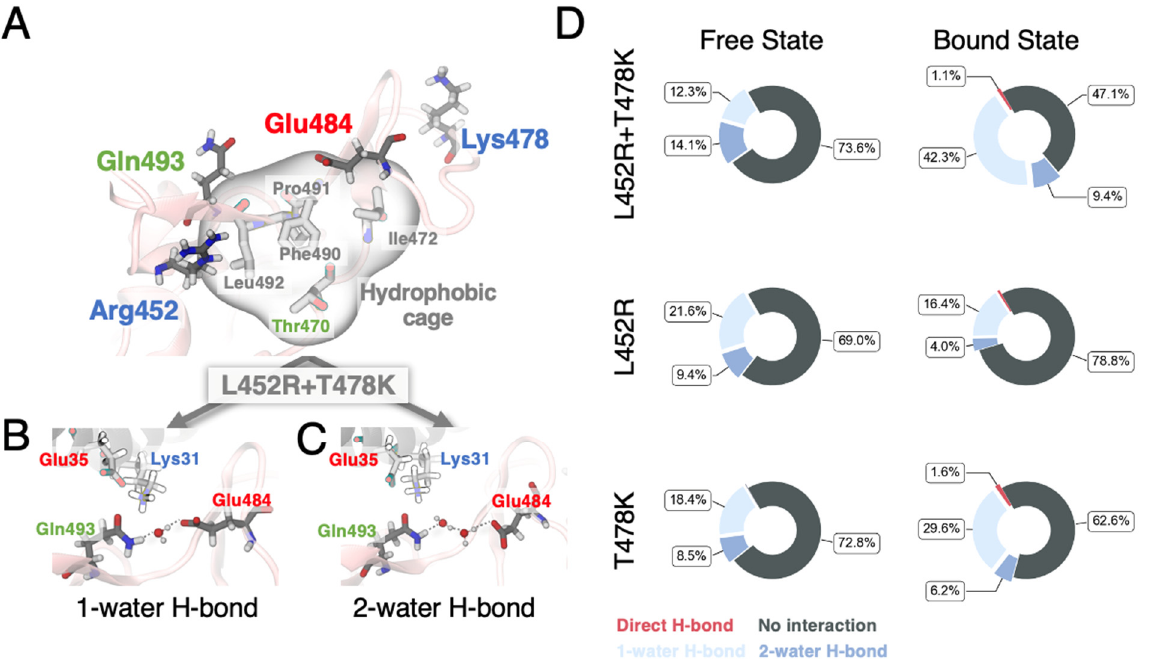
Figure 4. ( A ) Residual interaction network on the surface of RBD mut2 (L452R + T478K). Key residues were shown as sticks. The molecular surface of the hydrophobic cage was shown in transparent. ( B , C ) Snapshot from MD simulations showing hydrogen bond network between Gln493 and Glu484 mediated through one ( B ) or two ( C ) water molecule(s). ( D ) Statistics of polar interactions (direct or water-mediated hydrogen bonds) between Gln493 and Glu484 from FEP calculations.